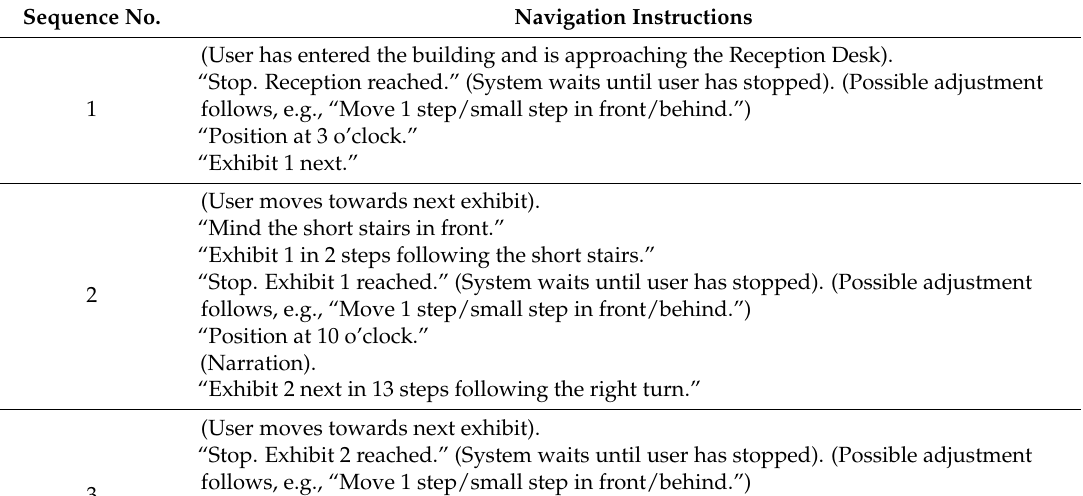
Table 2. Blind MuseumTourer navigation instructions